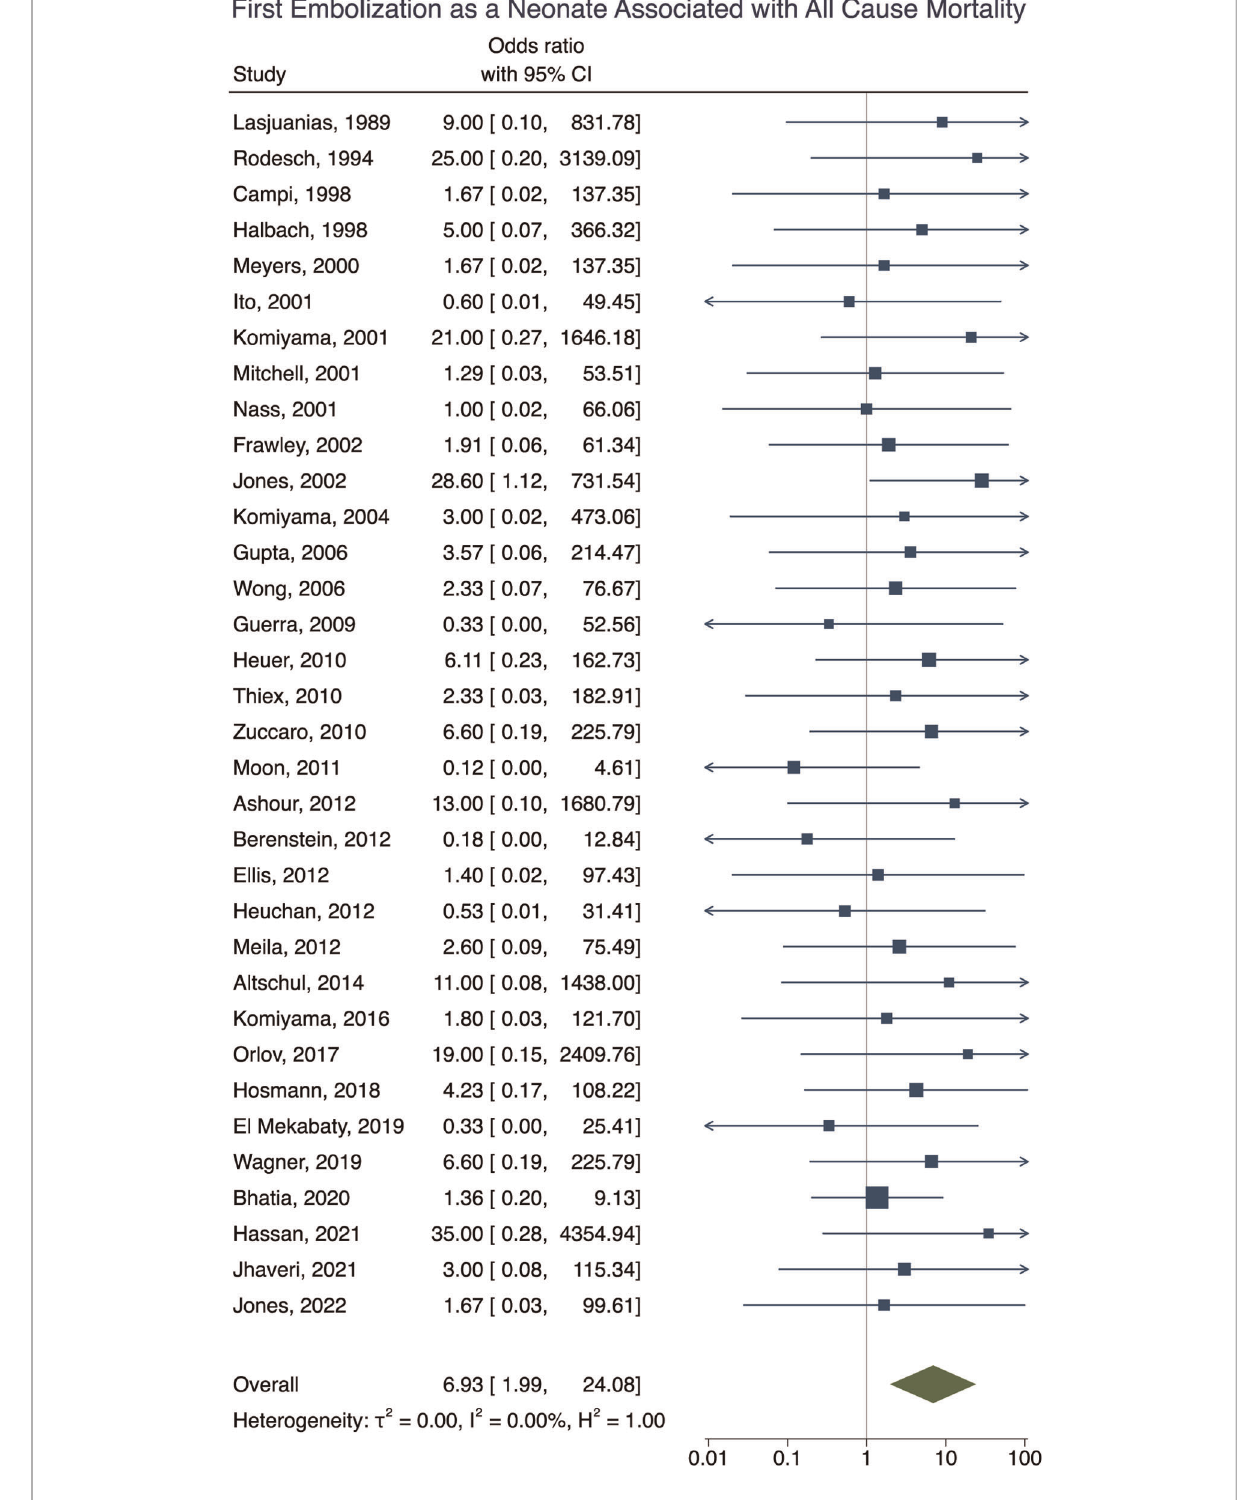
FIGURE 5 Forest plot showing the association of fi rst embolization as a neonate with all-cause mortality after VOGM